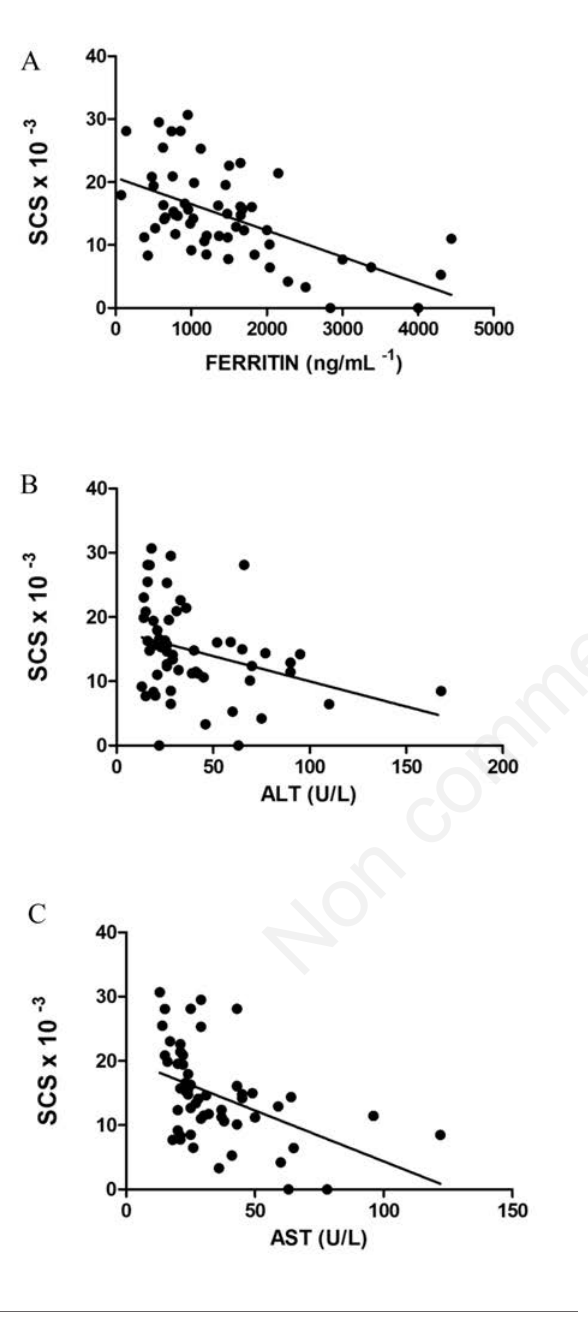
Figure 3. Correlation between skin carotenoid score (SCS) and plasma ferritin (A), alanine (ALT) (B) and aspartate transaminase (AST) (C) in b -thalassemia patients. Each value is the mean of two measurements during the year of the study. n=57; A) r=−0.569, P<0.0001; B) r=−0.292, P=0.027; C) r=−0.434, P=0.0007.